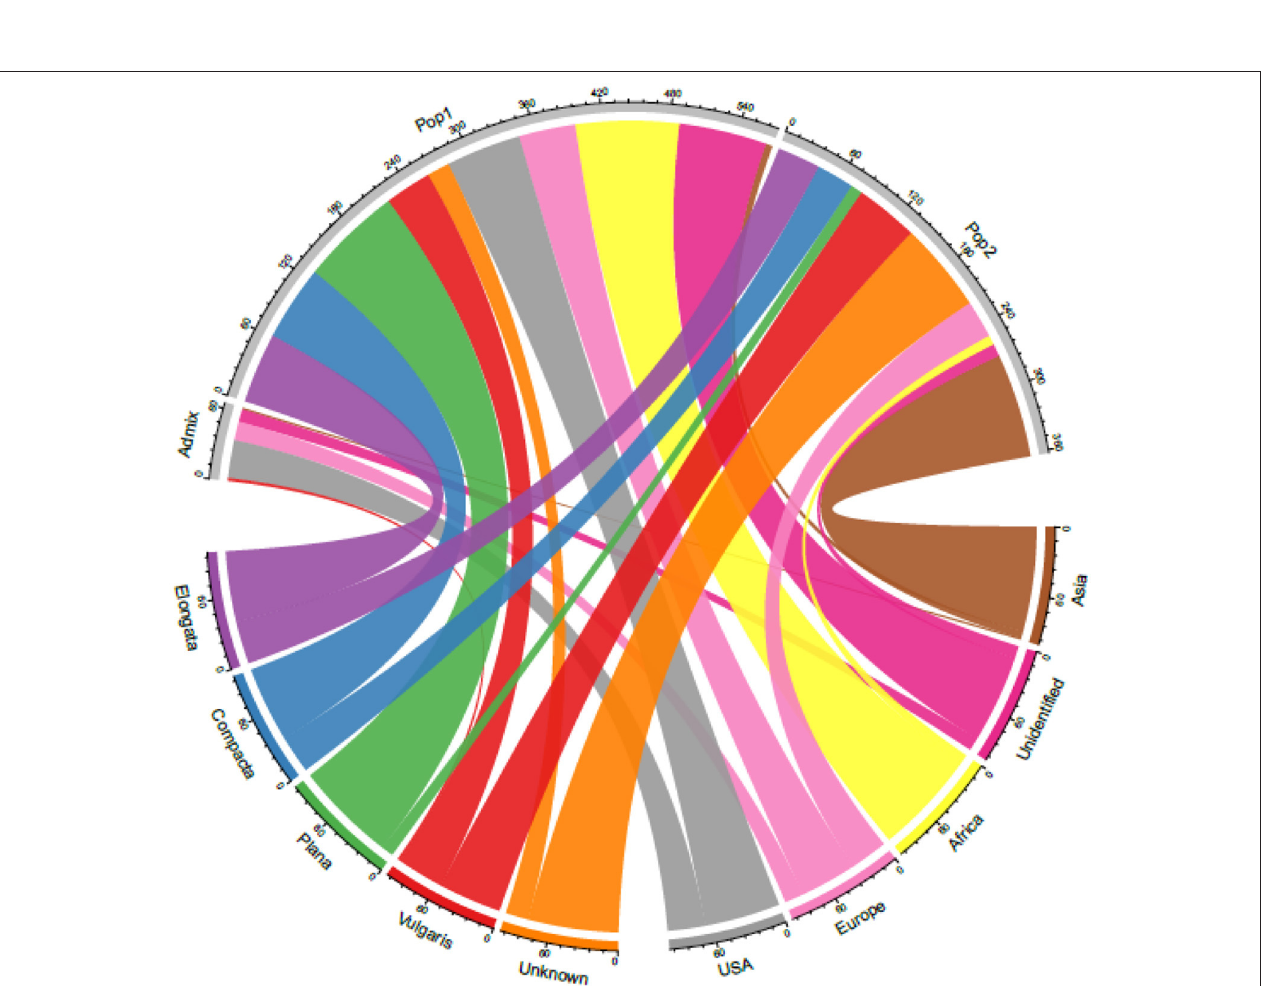
FIGURE 6 | A chord diagram showing the relationship between the STRUCTURE-based populations with the geographical origin and races in the 306 finger millet accessions.